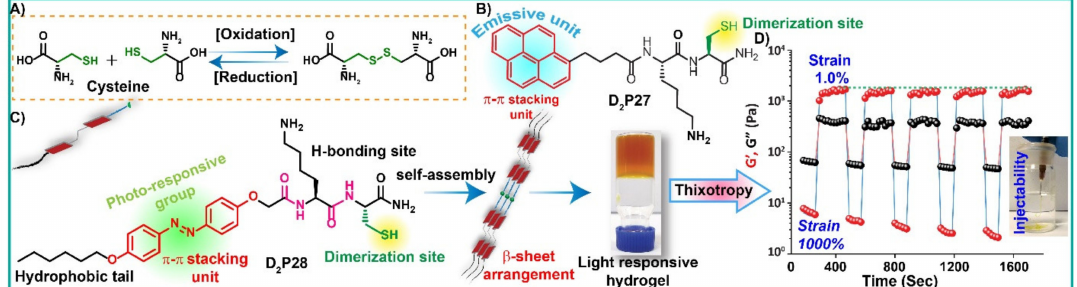
Figure 4. ( A ) Dimerization of two cysteine units. ( B ) Chemical structure of the pyrene-capped dipep- tide hydrogelator (D 2 P27); redrawn from Ref. [40]. Copyright is not applicable here. ( C ) Molecular structure and possible self-assembly of the Azo-capped dipeptide hydrogelator (D 2 P28). ( D ) Rheolog- ical step-strain analysis of D 2 P28, confirming thixotropicity. Inset: injectability behavior; reproduced with permission from Ref. [82]. Copyright (2020) Royal Society of Chemistry.